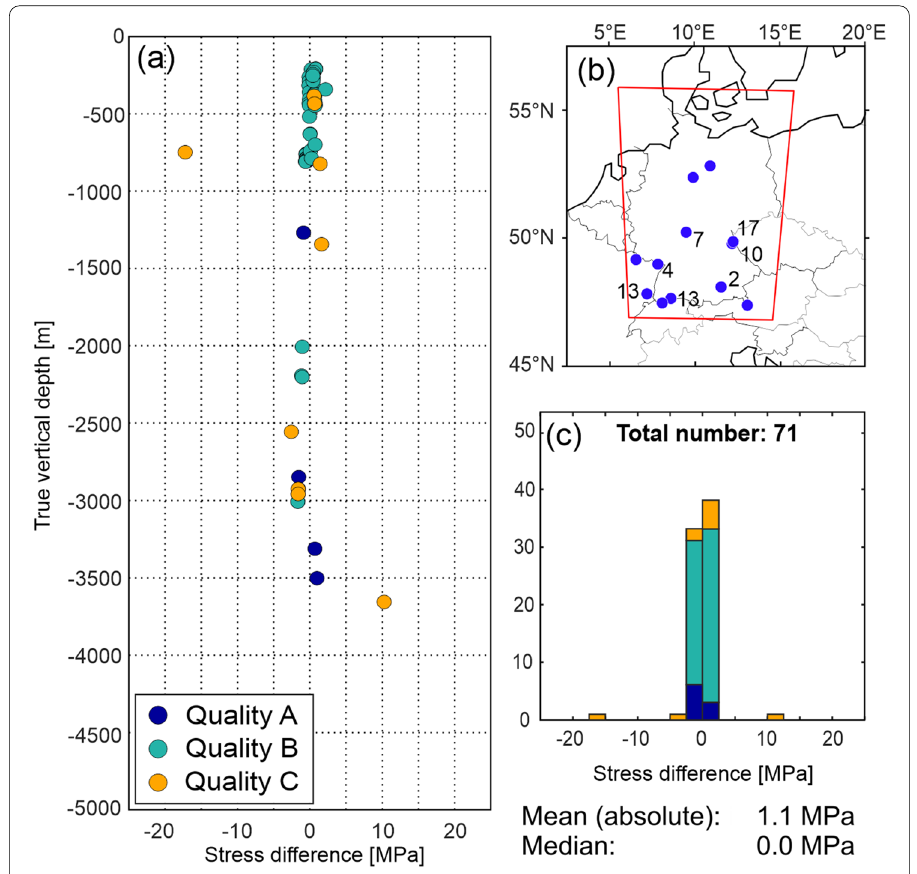
Fig. 10 S V magnitudes of the model in comparison to data of Morawietz and Reiter (2020). a Color‑coded differences versus depth. Differences are calculated as model results minus data of Morawietz and Reiter (2020). b Spatial distribution of stress magnitude data, used for comparison. Numbers indicate localities with multiple data. c Color‑coded histogram of the differences displayed in